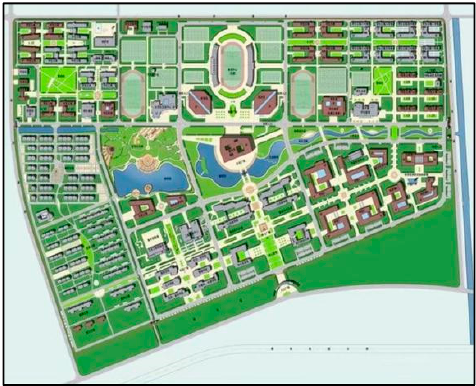
Figure 2. The areas of the case campus. Table 3. Basic information for target